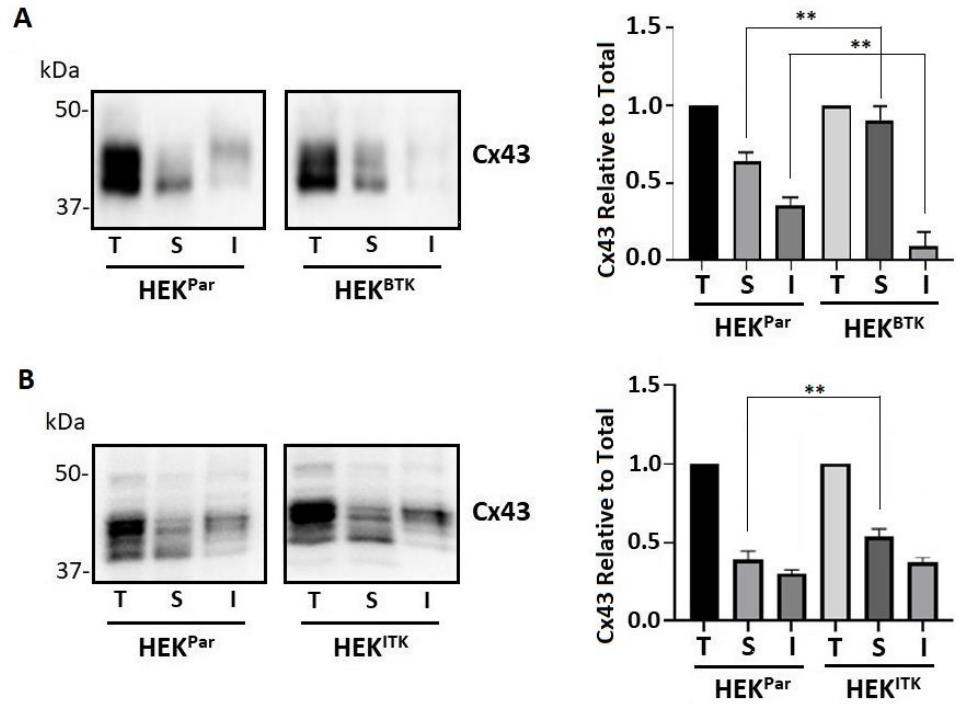
Figure 5. The effect of BTK and ITK phosphorylation on Cx43 regulation in the HEK-293T cells as observed through changes in detergent solubility. Cx43 was extracted with 1% Triton X-100 from HEK-293T parental (HEK Par ) and ( A ) stably expressing BTK (HEK BTK ) or ( B ) stably expressing ITK (HEK ITK ) cells. Equal amounts of the total protein fraction (T), the Triton X-100 soluble fraction (S), and the insoluble fraction (I) were subjected to SDS-PAGE and blotted with an antibody against Cx43. Bands were quantified using ImageJ (all units measured in pixels) and GraphPad Prism. Statistical data represent one-way ANOVA ( n = 3, ** p < 0.01).